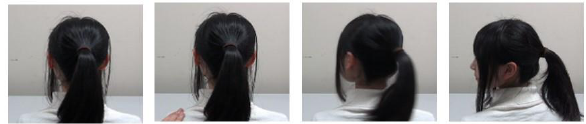
Figure 4. Video stimulus with Pepper.